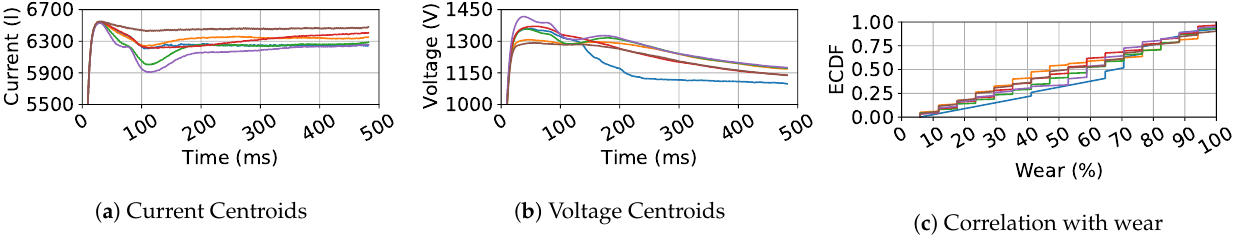
Figure 17. Clusters representation wp Working Station 2 Clamp 1, Steady-State aligned Data